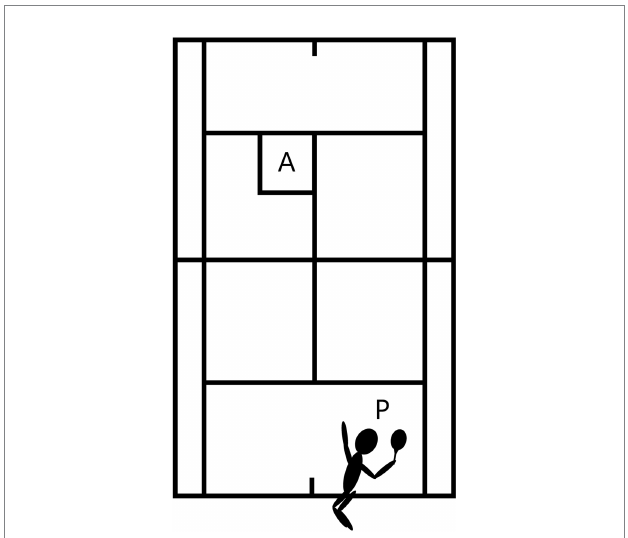
FIGURE 1 Serve accuracy. The subjects served 20 times from point P to the left side of the serve box, aiming at target A. Serve accuracy was determined as the number of serves that successfully hit target A out